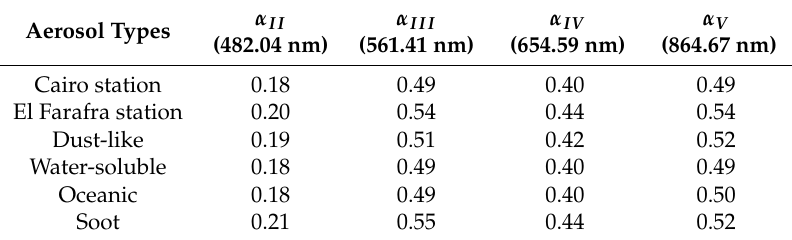
Table 5. Surface albedo averaged by the pixels over the study area at Landsat resolution for the second to the fifth OLI channels. The values refer to the surface albedo obtained from the OLI image atmospherically corrected with AERONET inverse products and the microphysical properties of the four basic components of the aerosol included in 6SV (dust-like, water-soluble, oceanic, soot [25]). Aerosol